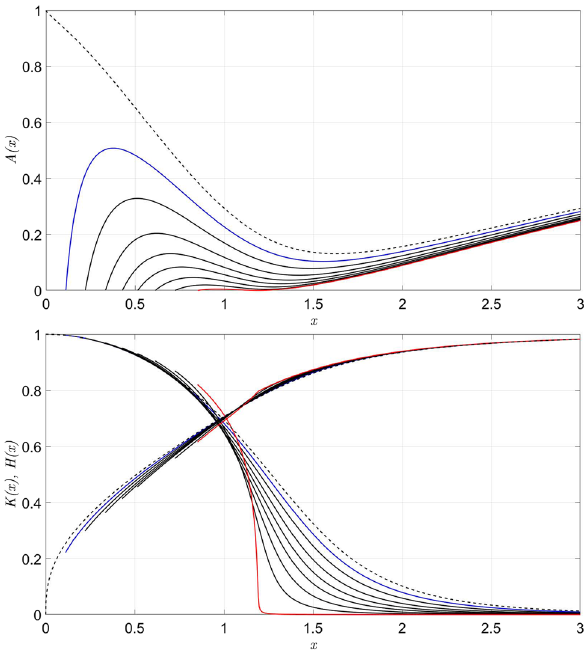
Fig. 5 Black hole in electroweak monopole solutions with α = 1 . 6, physical β and Weinberg angle, plotted as a function of x for x H = 0 . 1111 (blue), 0 . 2195 , 0 . 3333 , 0 . 4286 , 0 . 5152 , 0 . 6129 , 0 . 7241 and 0 . 8519 (red). Dashed lines indicate regular gravitating solutions